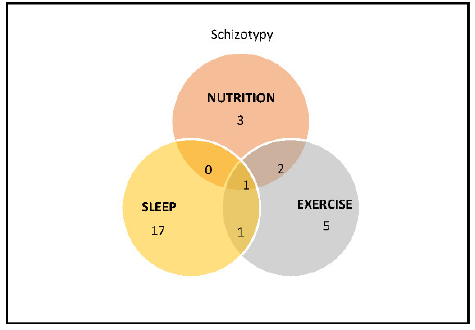
Figure 2. Venn diagram of studies of schizotypy and its overlap in different topics.